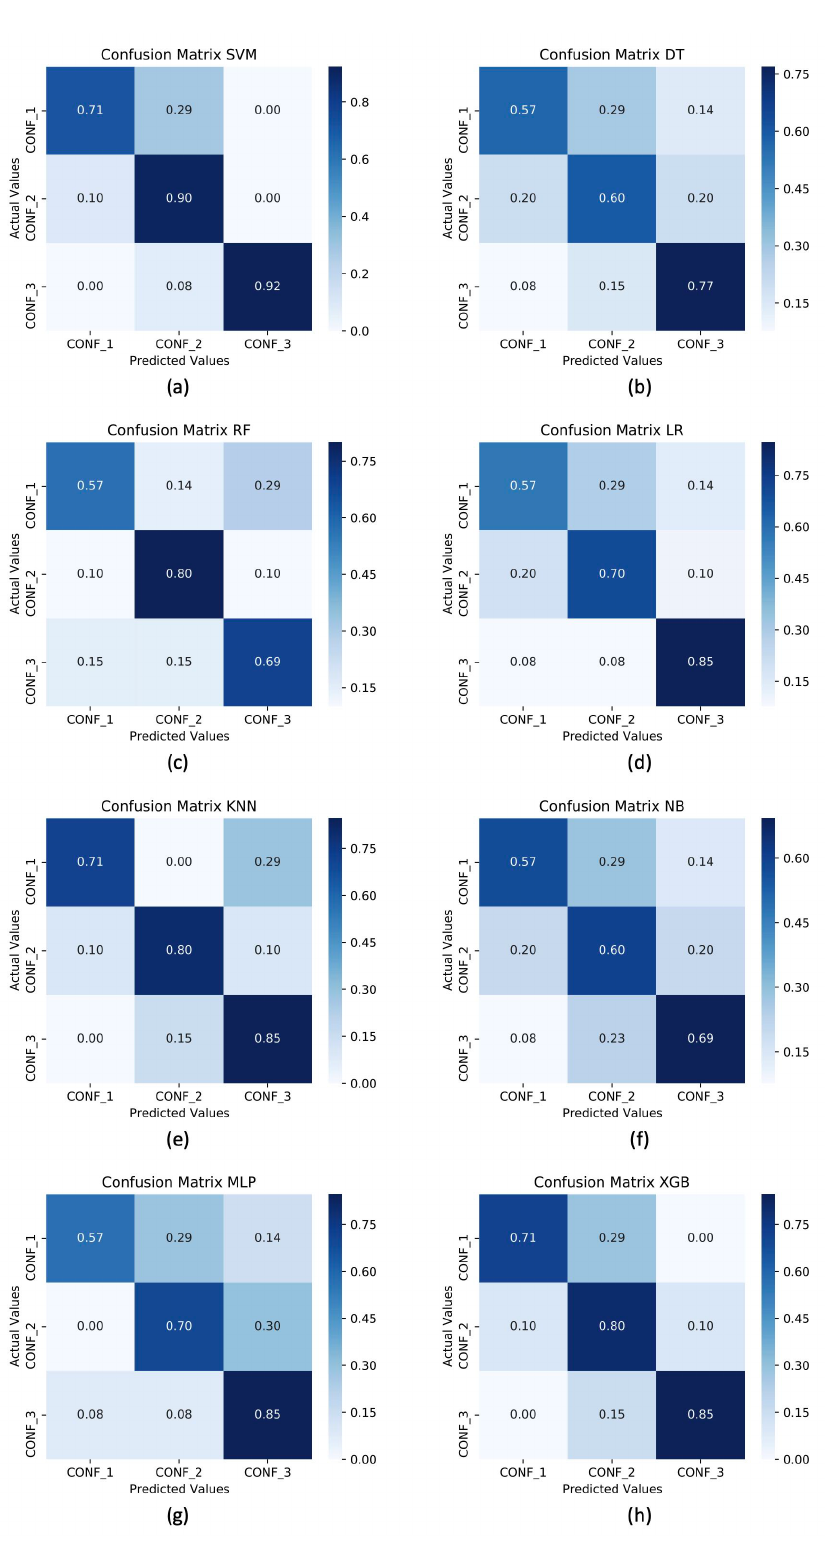
Figure 5. Confusion matrices for three classes of sarcopenia confidence levels using ( a ) SVM, ( b )